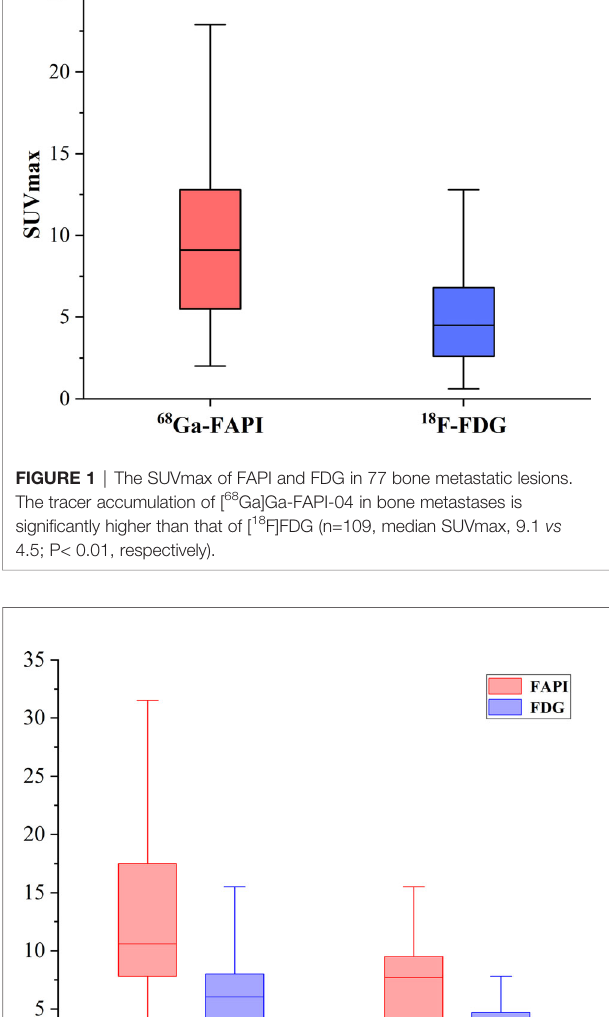
(n = 5) and liver cancer (n = 5). [ 68 Ga]Ga-DOTA-FAPI-04 uptakes were signi fi cantly higher than that of [ 18 F]FDG in bone metastases from lung cancer (n = 62, median SUVmax, 10.7